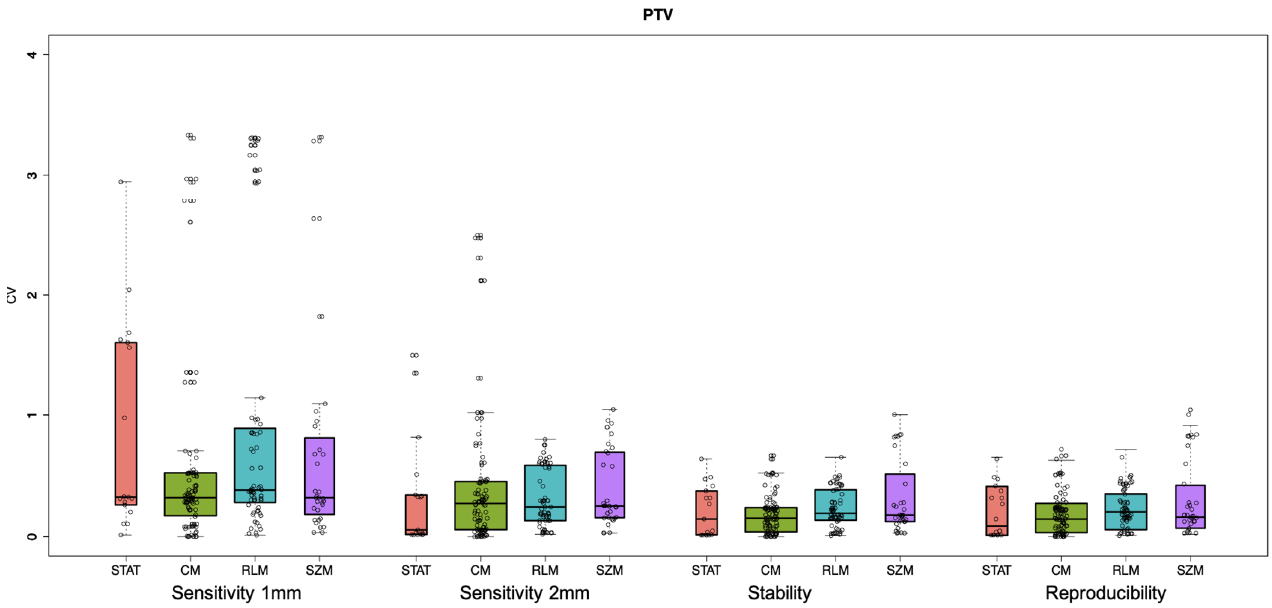
Figure 5. Box plots of the CV values for the sensitivity (1 mm and 2 mm), stability and reproducibility studies grouped for the four different features’ families (STAT, CM, RLM and GSZ) for the PTV .